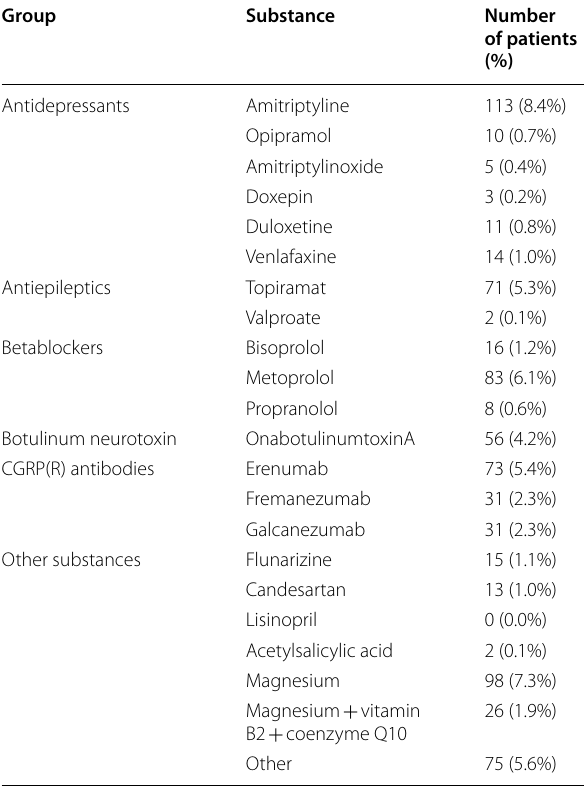
Table 5 Preventive headache medication